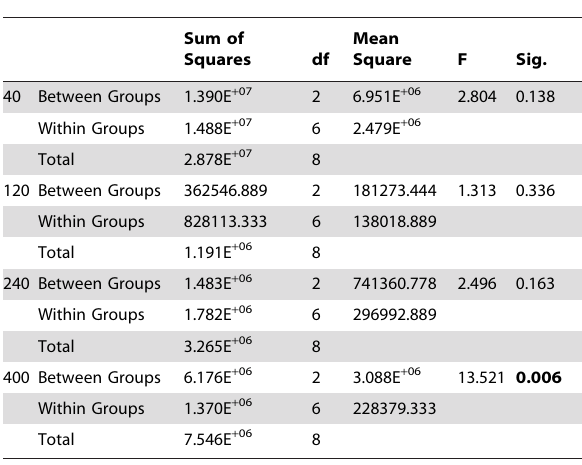
Table 5. One-way ANOVA of the maximum aphid numbers recorded within the different treatments (initial aphid densities) and sub-treatments (‘‘Predators’’, ‘‘Predators + Parasitoids’’ and ‘‘Parasitoids’’).